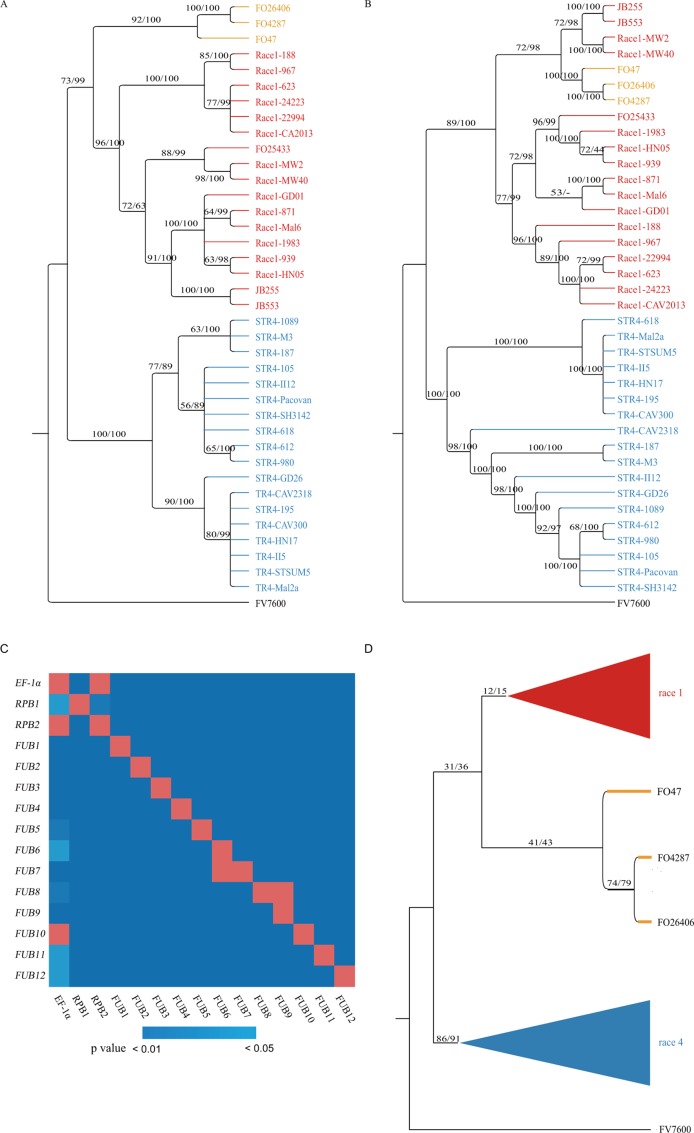

Foc infraspecies phylogeny inference and discordance between phylogenetic trees based on different genes. (A and B) Phylogenetic trees constructed based on concatenated sequences of EF-1α/RPB1/RPB2 and the 12 FUB genes, respectively. The support values on the branches are ML bootstrap proportions/BI posterior probabilities. R1, R4 and 3FO isolates were denoted by red, blue, and orange colors respectively. (C) SH test of the tree concordance between different genes. The best ML tree based on genes listed on the vertical axis was tested using the best tree and sequence of the gene listed on the horizontal axis. The color of the squares was determined by the p value of the SH test: blue indicated significance, and red indicated nonsignificance (p > 0.05). (D) Infraspecies tree inferred using the BSRRSS method. The numbers on branches are the support rates of the branch in 1,000 randomly sampled 1-kbp/2-kbp gene segments.